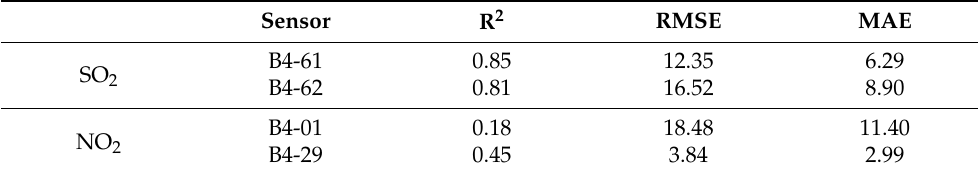
Table 9. Performance metrics of the calibrated sensors in the testing period. RMSE and MAE are expressed in concentration units ( µ g m 3